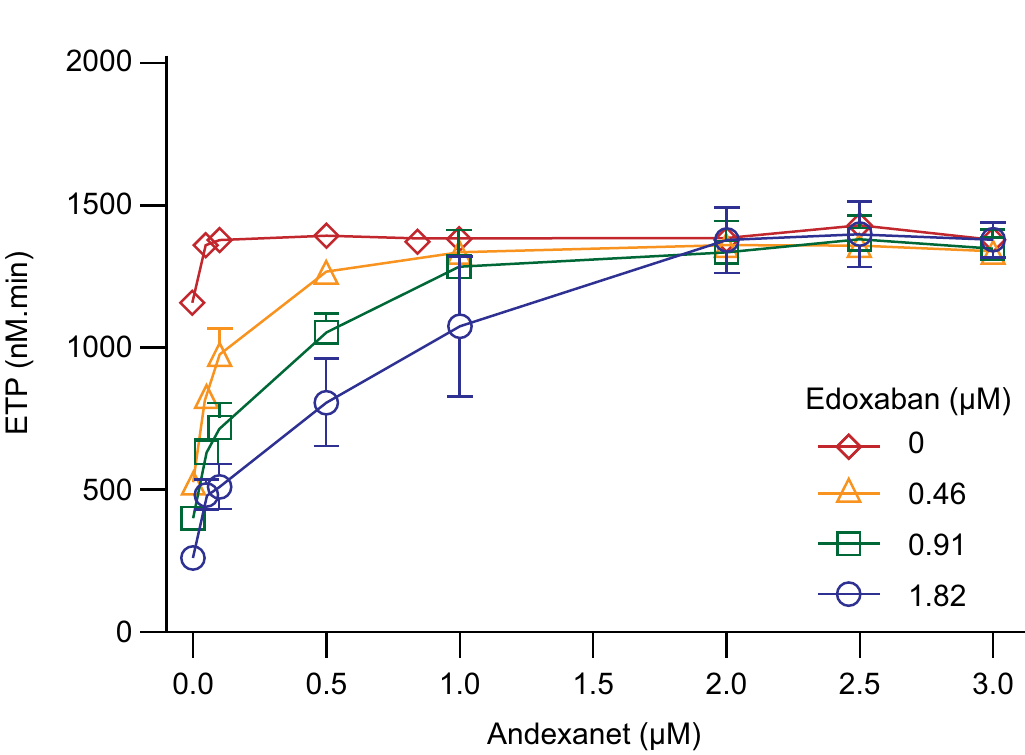
Fig 4. In vitro reversal of edoxaban-induced inhibition of thrombin generation in human plasma. Plasma samples contained edoxaban at 0 ( (cid:5) ), 250 ( 4 ), 500 ( □ ),and 1000 ( (cid:14) ) ng/mL (0, 0.46, 0.91, 1.82 μ M) and increasing concentrations of andexanet (0, 0.05, 0.1, 0.5, 1.0, 2.0, 2.5, 3.0 μ M). Data (ETP) were plotted as mean ± standard deviation from two separate experiments. Additional thrombin generation parameters are provided in S2